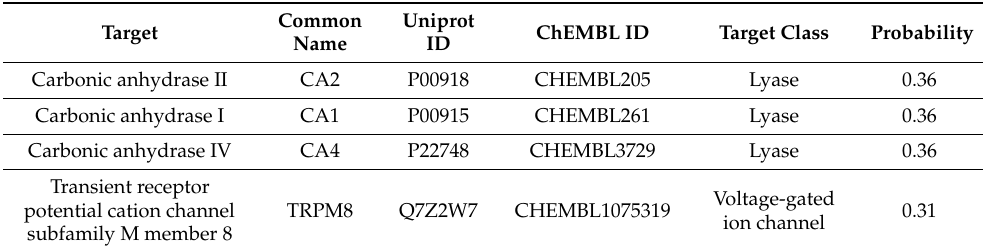
Table 10. Main molecular targets of the phytochemical borneol obtained through the analysis in Swiss Target Prediction [102].